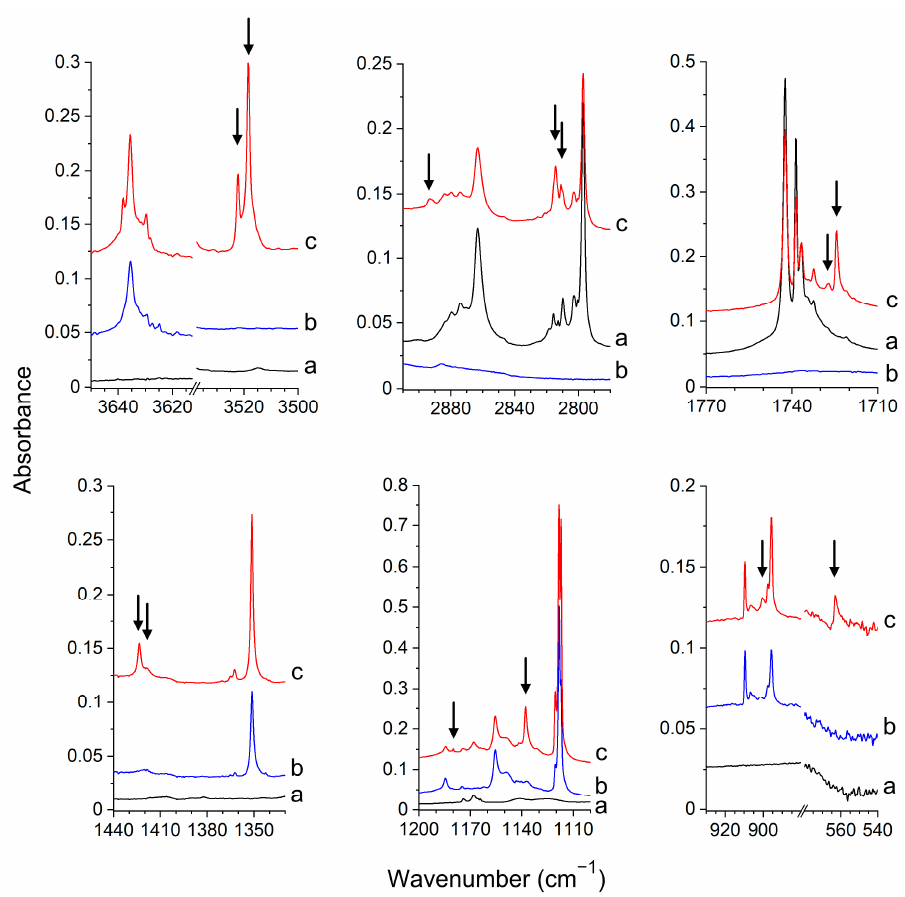
Figure 2. The spectra of the HCHO/Ar (a), NH 2 OH/Ar (b) and HCHO/NH 2 OH/Ar (c) matrices recorded after matrix deposition at 11 K. The bands of the HCHO–NH 2 OH complex are marked by the arrows.